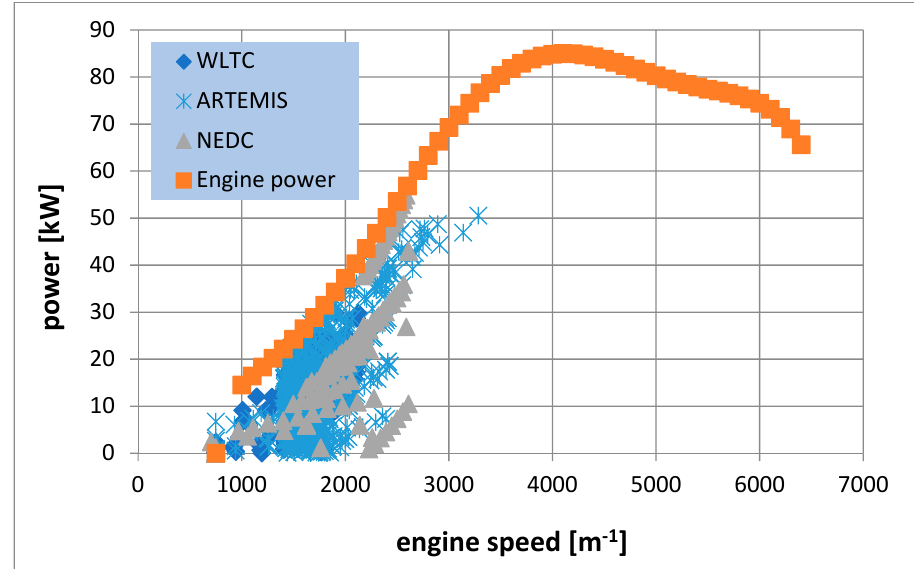
Figure 2. The required road load power versus engine speed for phases of ARTEMIS, WLTC and NDEC driving cycles corresponding to urban traffic conditions.